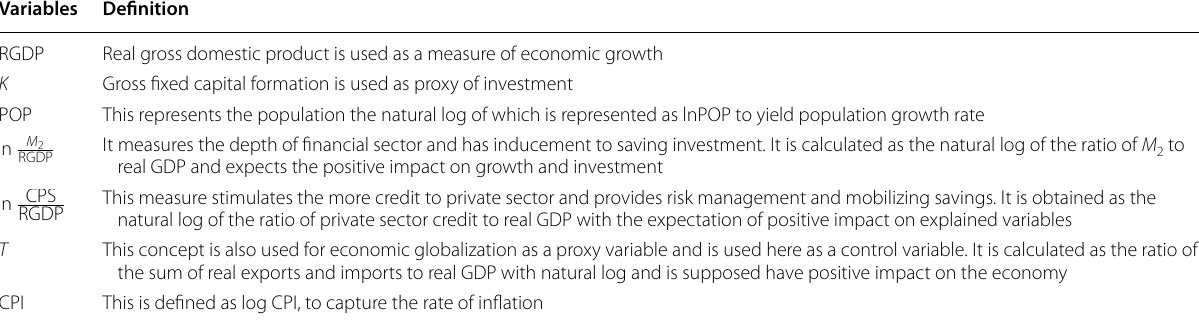
Table 1 Description of variables. Source : Compiled by the Researchers, 2017 Variables Definition RGDP